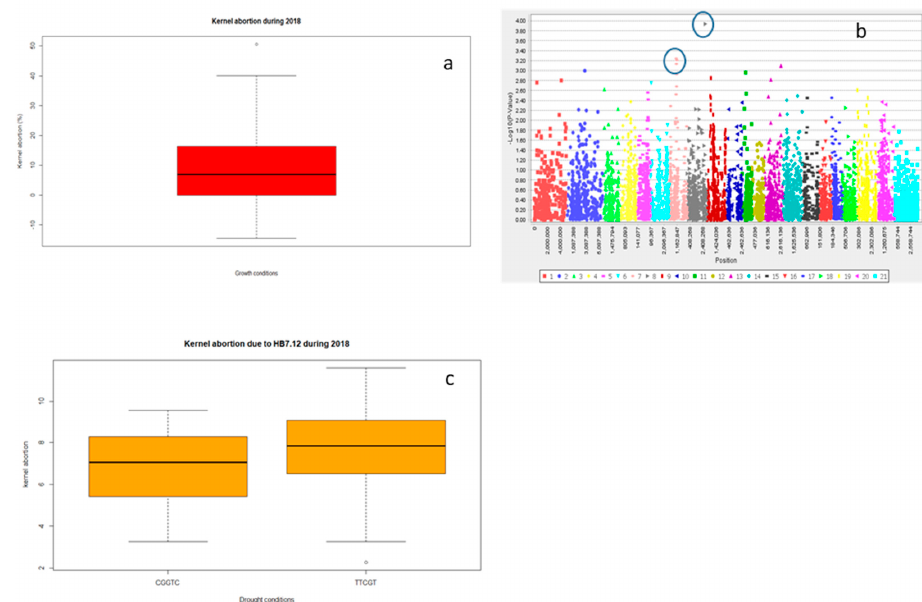
Figure 4. Boxplot showing variation in kernel abortion under drought during 2018 ( a ). marker trait association through GLM under drought 2018 ( b ) and haplotype block (HB) 7.12 showing differences in kernel abortion ( c ). Int. J. Mol. Sci. 2019 , 20 , x FOR PEER REVIEW